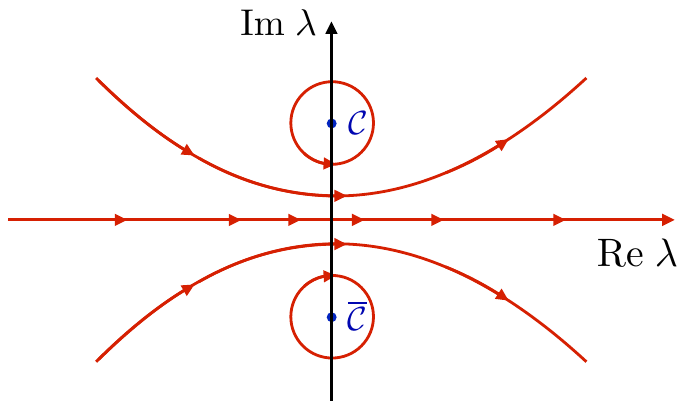
Figure 2 . Structure of RG (cid:13)ow in the complex coupling plane, in the approximation of